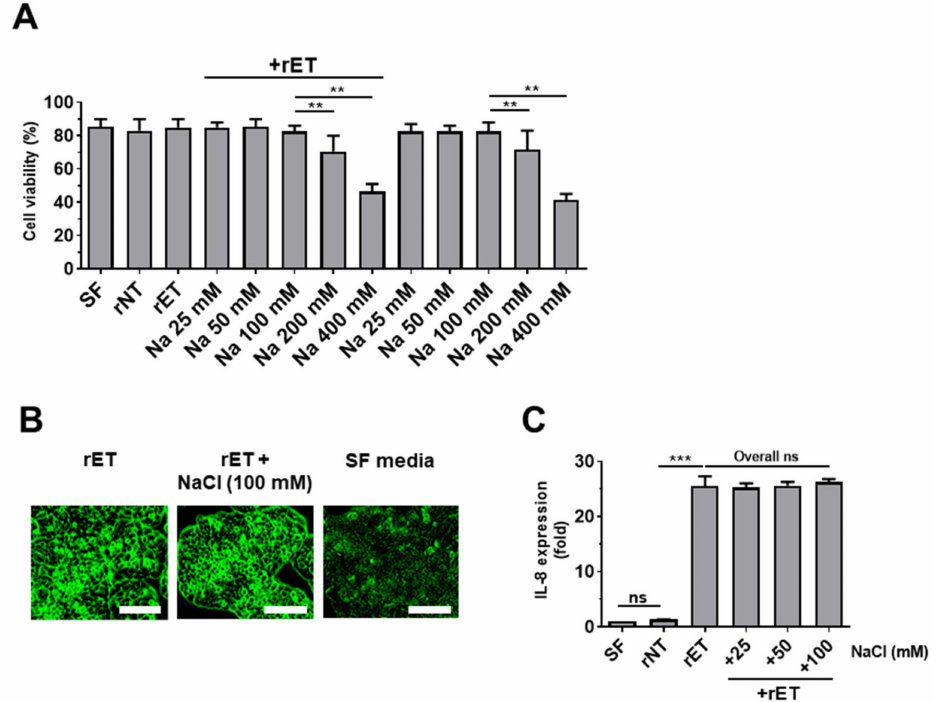
Figure 6. The e ff ect of sodium chloride on BFT-induced cellular morphology and IL-8 expression in HT29 / C1 cells. HT29 / C1 cells were treated with sodium chloride with or without rETBF (rET) culture supernatants (1:10). ( A ) Cell viability of HT29 / C1 cells treated with sodium chloride (25 to 400 mM) chloride with or without rETBF (rET) culture supernatants (1:10) for 24 h. ( B ) Cell morphology changes. HT29 / C1 cells were treated with rETBF (rET) supernatant (positive control) alone or rETBF (rET) supernatant with 100 mM NaCl. Serum-free cell culture media (SF) was used as a negative control. Cellular morphologic change was examined by microscopy. Magnification, × 400. Scale bar, 100 µ m. ( C ) Real time-PCR analysis of IL-8 expression in HT29 / C1 cells treated with rETBF (rET) or rNTBF (rNT) culture supernatant and sodium chloride (25–100 mM) for 3 h. Data are expressed as the means ± SEMs from three independent experiments. ** p < 0.01; *** p < 0.001; ns, no statistical